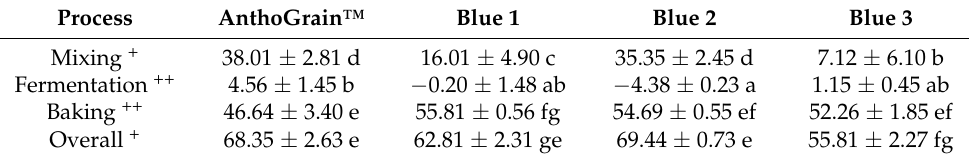
Table 5. Loss of total anthocyanin content (expressed as %) at each bread processing